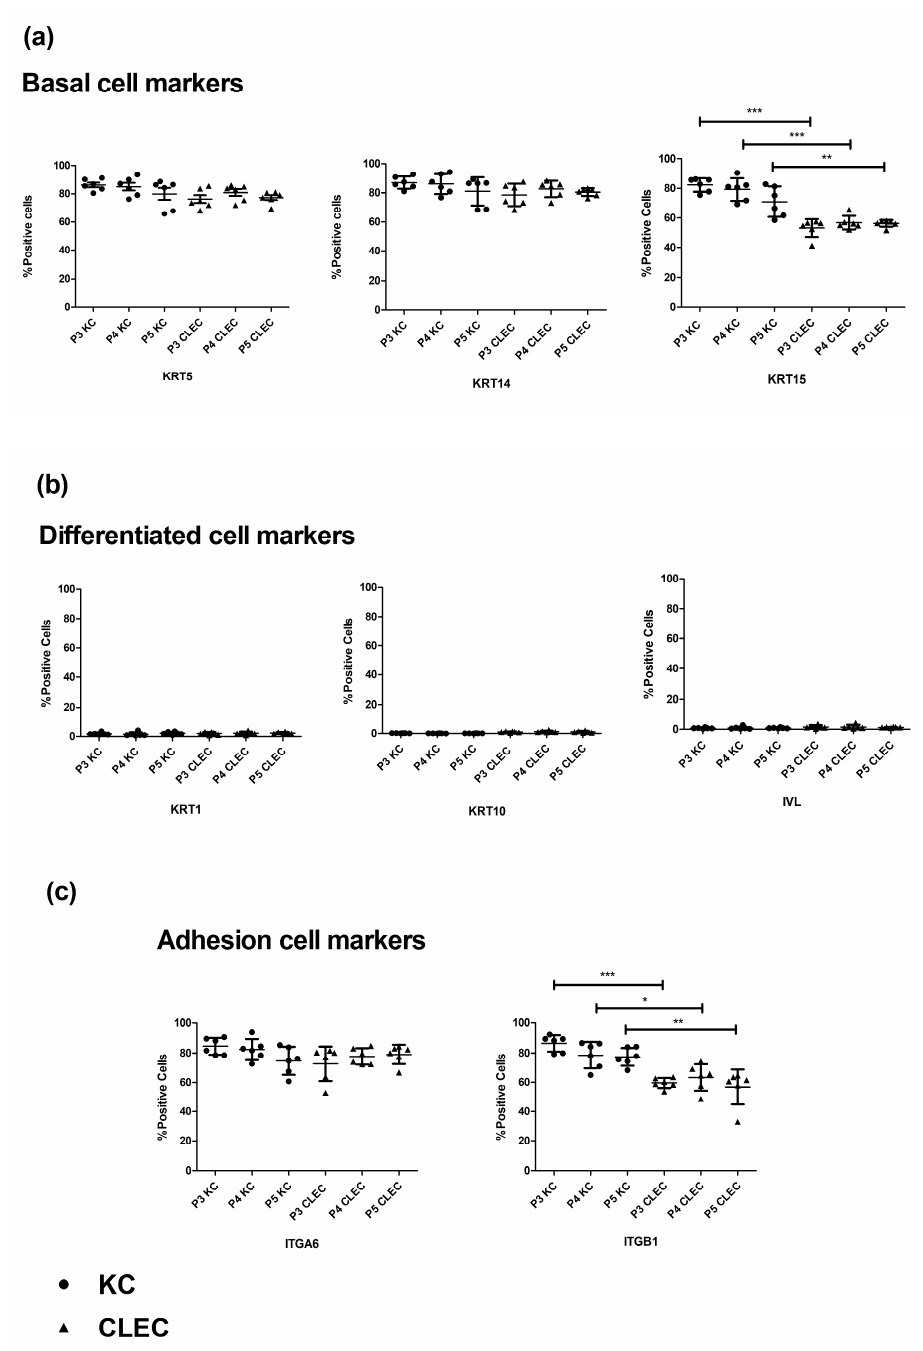
Figure 1. Dot plots based on flow cytometry analysis of passages three to five KCs and CLECs (three donors each cell type with two technical replicates), depicting the immunophenotypic expression levels of epidermal ( a ) basal cell markers using KRT5, KRT14, and KRT15; ( b ) differentiation cell markers using KRT1, KRT10, and IVL; and ( c ) adhesion cell markers using ITGA6 and ITGB1. Center line of the dot plots is the mean, and the whiskers represent standard deviation (SD). Statistical analysis was performed using one-way ANOVA—Bonferroni’s Multiple Comparison Test (n = 6); * p < 0.05, ** p < 0.001, and *** p < 0.0001.